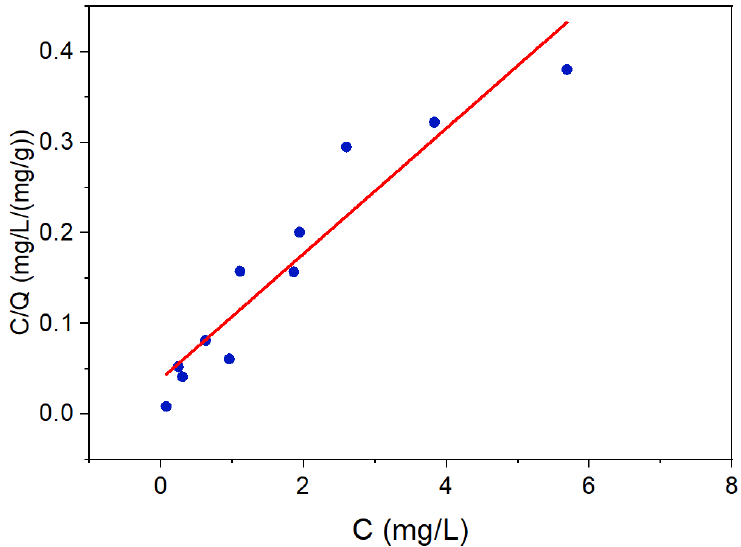
Figure 7. Langmuir isotherm fitting for selenate removal using LDH-TiO 2 matrix.